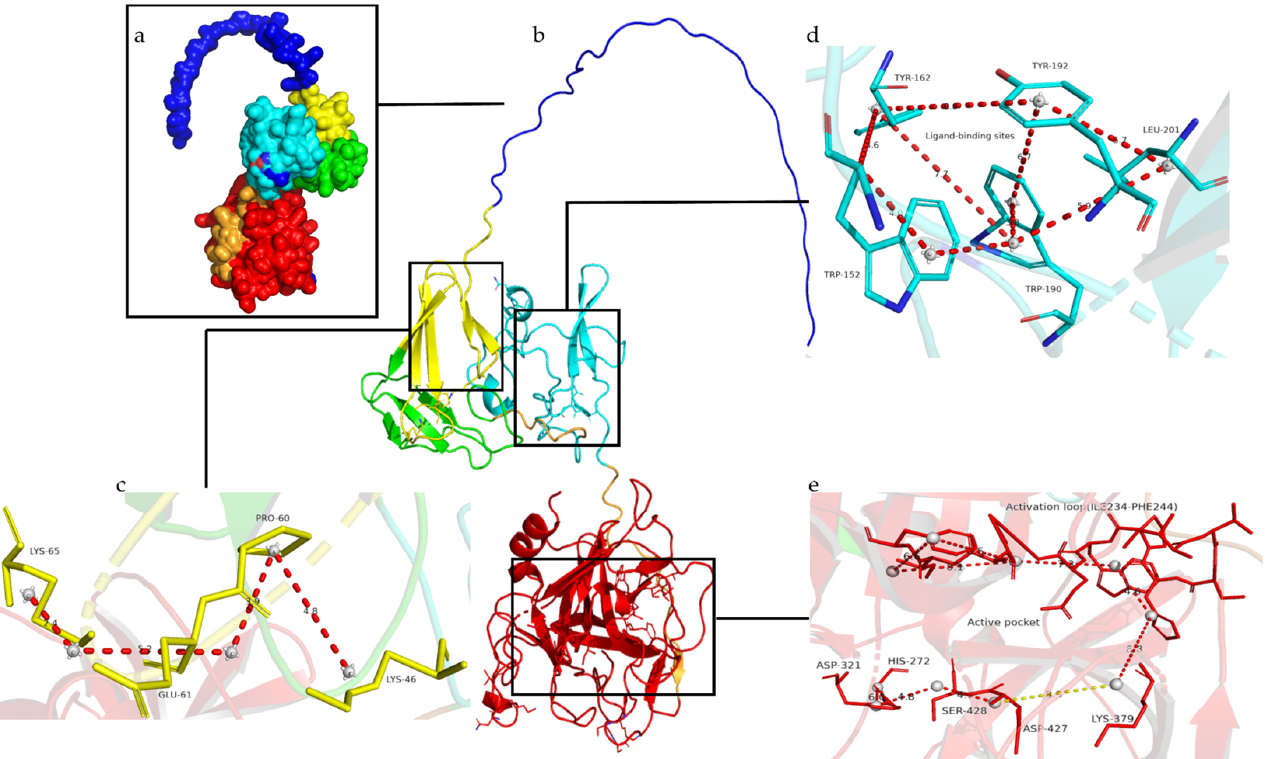
Figure 2. The Homology model of DSPA α 2. ( a ) The solvent-accessible surface of DSPA α 2. ( b ) The base ladders represent the internal structure of DSPA α 2. The blue lines represent the signal peptide, yellow helices and sheets represent the F region, green represents the EGF region, cyan represents the K1 region, and red represents the P region. ( c ) A detailed view of the fibrin-sensitive-related sites in the F region. The yellow and blue sticks represent amino acids, and the red dotted lines represent the interaction distance between residues. ( d ) A detailed view of the ligand-binding sites in the K1 region. Amino acids are represented by cyan and blue sticks. The red dotted lines represent the interaction distance between residues. ( e ) A visual of the active pocket. Amino acids are represented by red sticks. The red dotted lines represent the interaction distance between residues, and the yellow dotted line represents the salt bridge connecting K379 and D427.